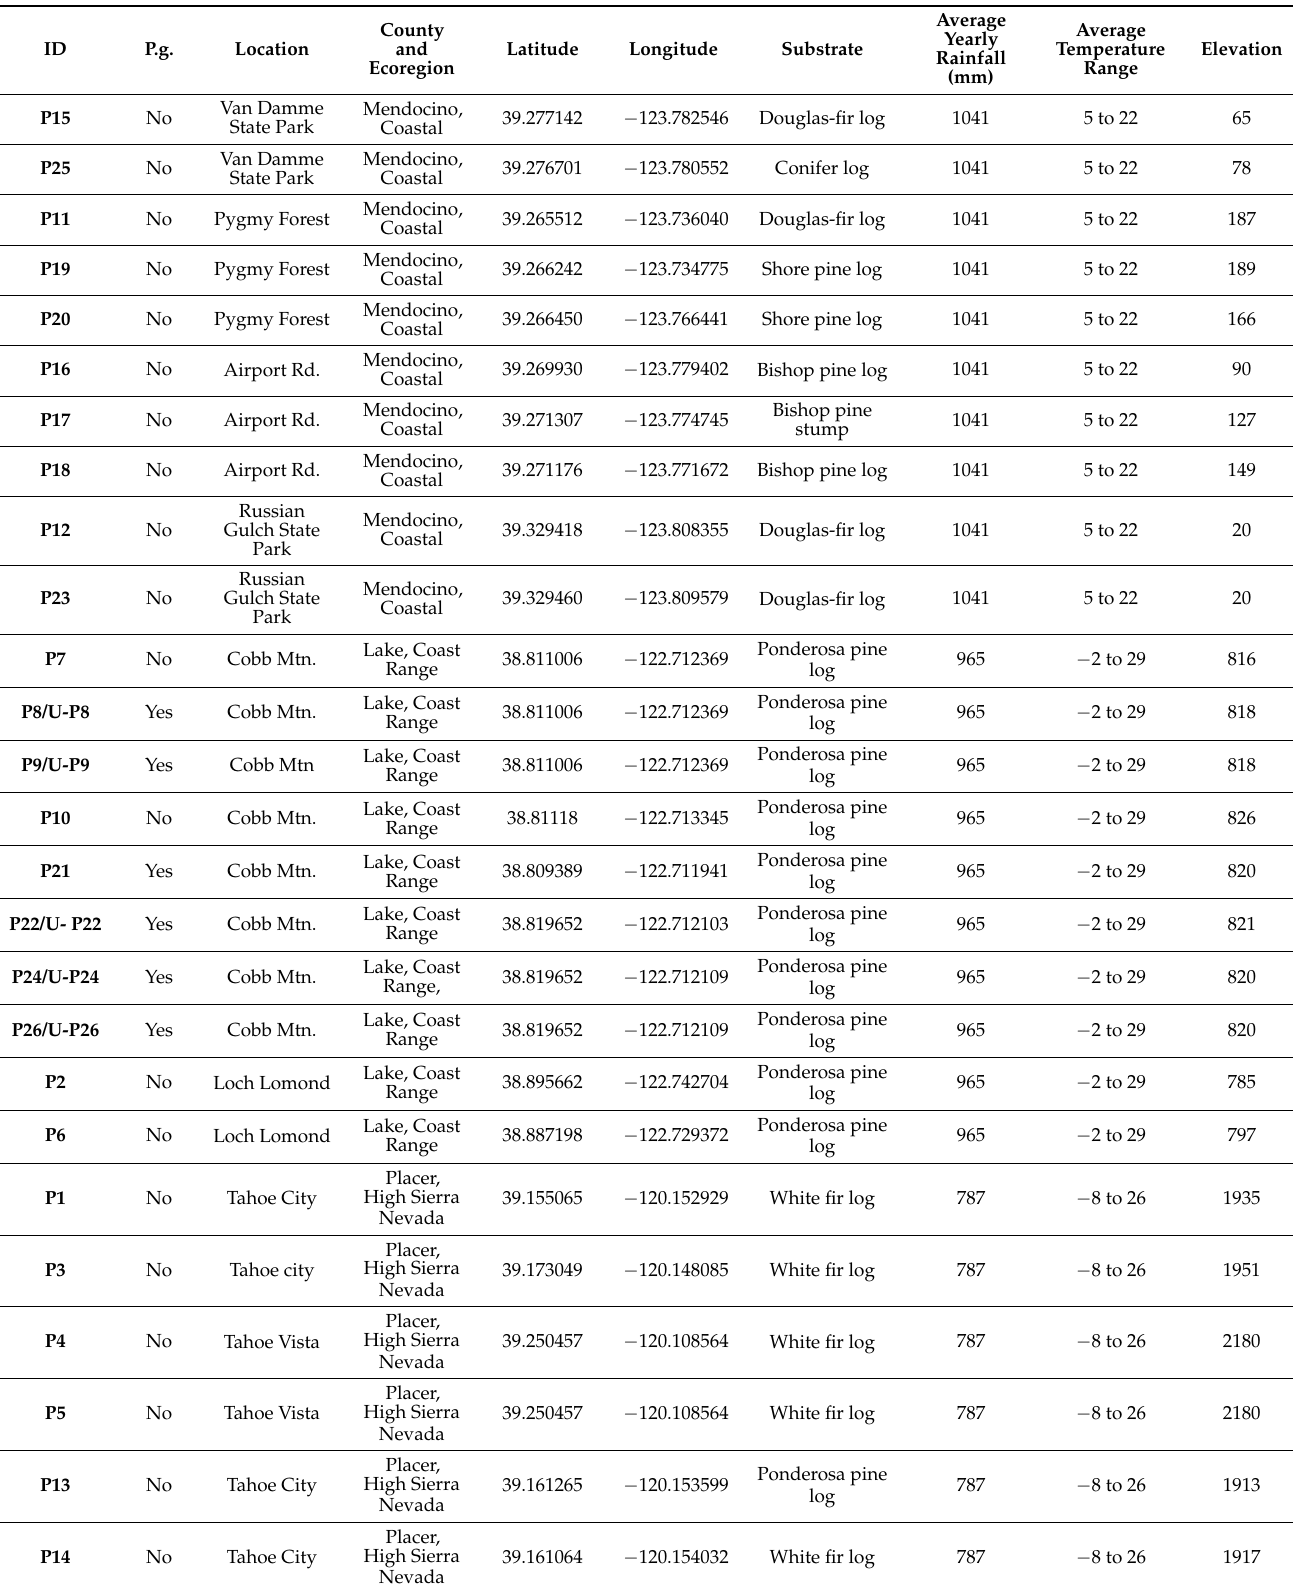
Table 1. Sampling points, location, substrate, climate and elevation of intensively surveyed mixed conifer forests in